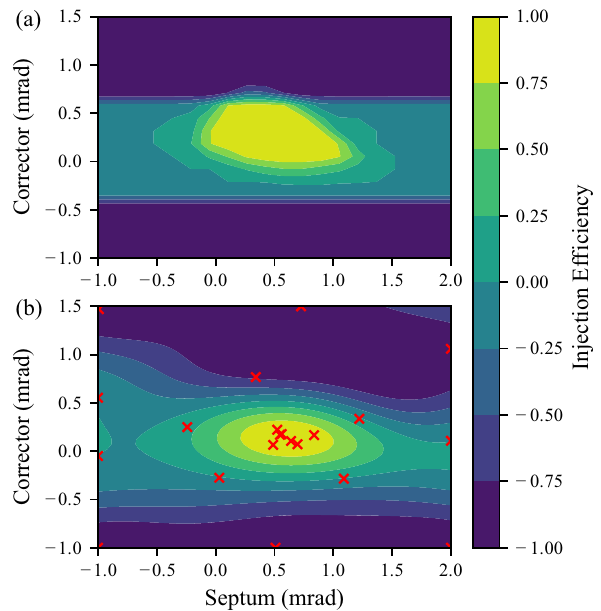
FIG. 3. Comparison of (a) a two-dimensional grid scan (grid size 400) of the injection efficiency with (b) the GP posterior mean predicted based on 20 BO evaluation steps, shown in red crosses. The tuning parameters are the strengths of the horizontal corrector magnet and the septum magnet, given in deflection angles. The BO can approximate the simple structure of para- meter space in a small number of evaluation